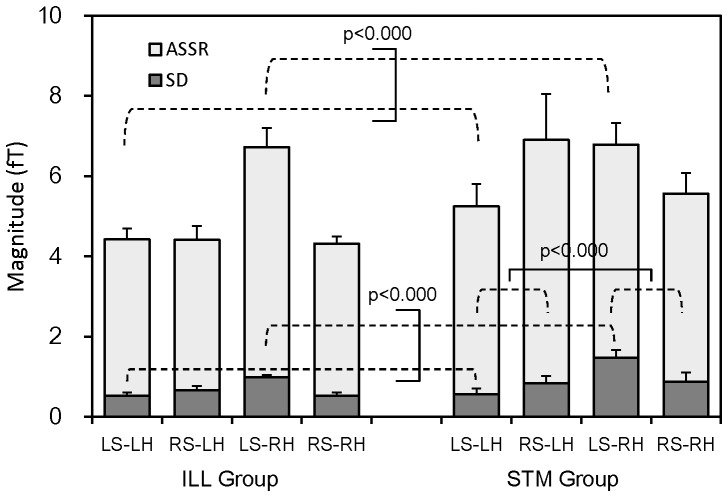
Grand-mean magnitude across stimulus tones and subjects of the ASSRs elicited by left and right sounds (LS and RS) in the left and right hemispheres (LH and RH).Results obtained for illusion (ILL) and stimulus (STM) groups are separately shown. Subject-mean of the standard deviation (SD) across stimulus tones of the ASSR magnitude is also shown. Note that the magnitude of ASSR is represented by the height of columns from zero line. Vertical bars indicate standard errors (SE) across subjects in each group (n = 6).